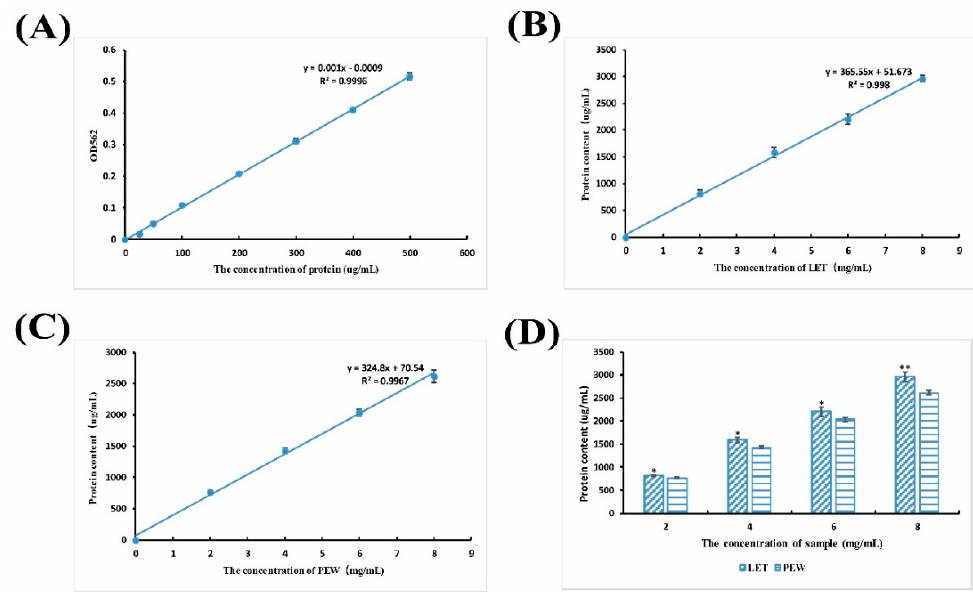
Figure 3. ( A ) Albumin standard curve in the BCA Protein Assay. ( B ) Protein content in LET. ( C ) Protein content in PEW. ( D ) Comparative analysis of the protein content in LET and PEW. Data are shown as the means of three independent experiments, the bars indicate ± SD. * p < 0.05 and ** p < 0.01 show significant differences between LET and PEW.